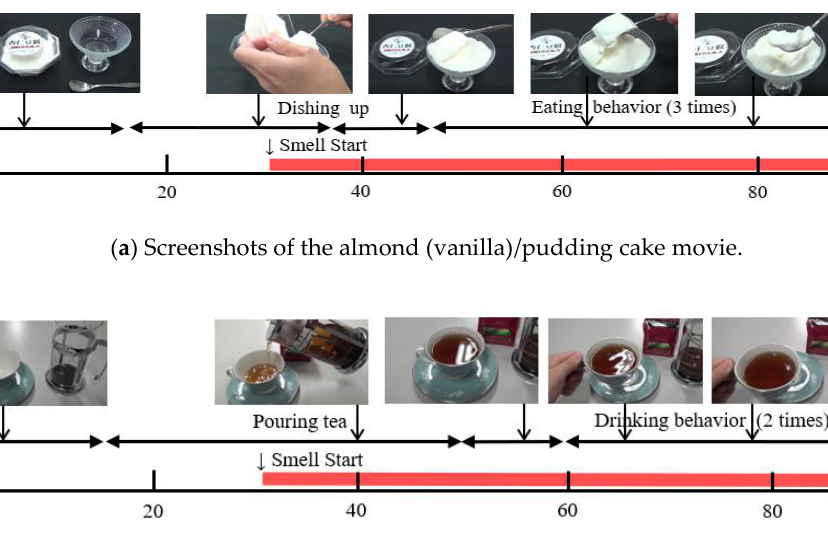
Figure 7. Storylines of food movies for STUDY 2.